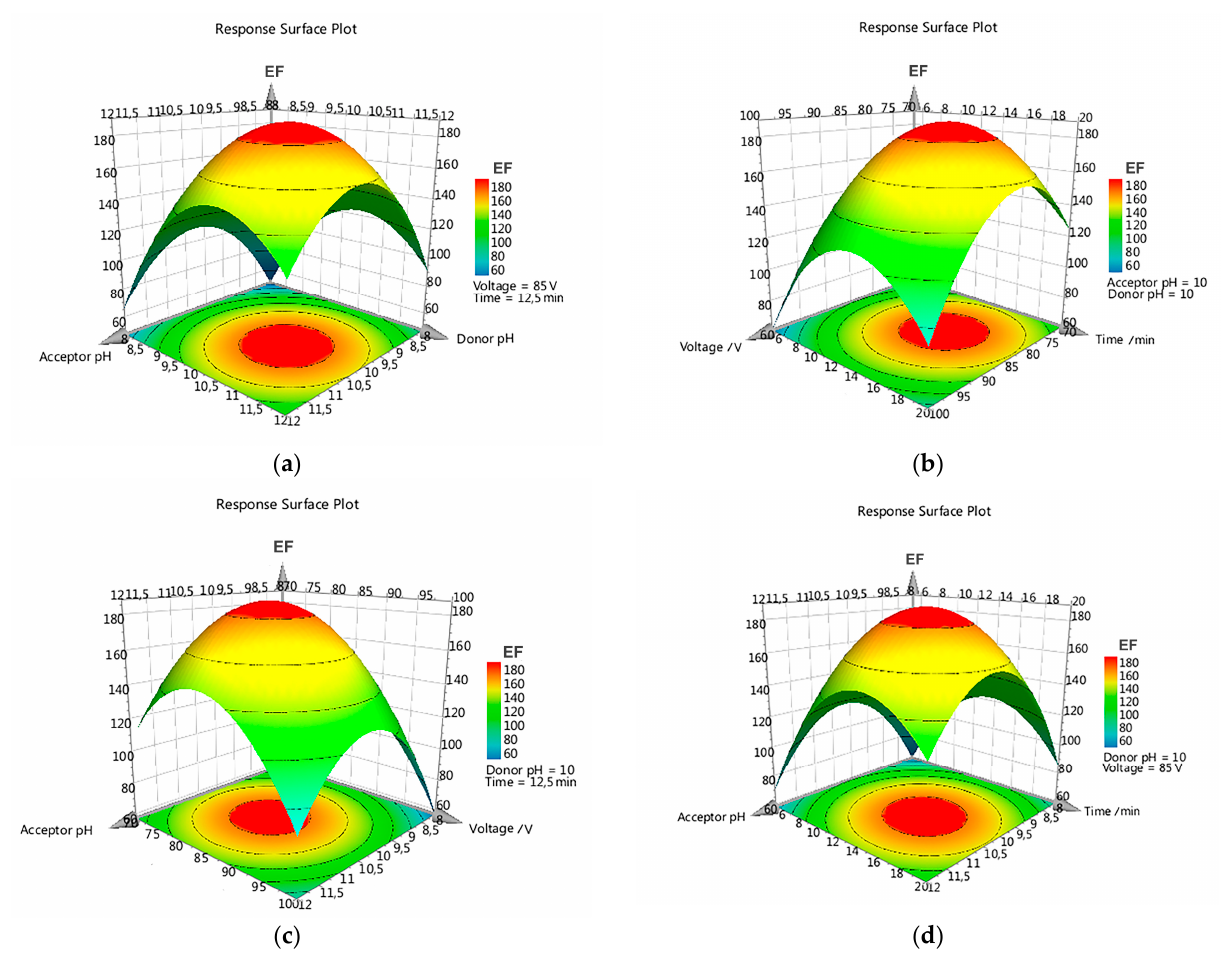
Figure 2. Three-dimensional response surface profiles for PrP. Plots of Enrichment Factor (EF, z-axis) as function of ( a ) acceptor phase pH and donor phase pH; ( b ) applied voltage and extraction time; ( c ) acceptor phase pH and applied voltage; ( d ) acceptor phase pH and extraction time. All other factors were set to their central value.